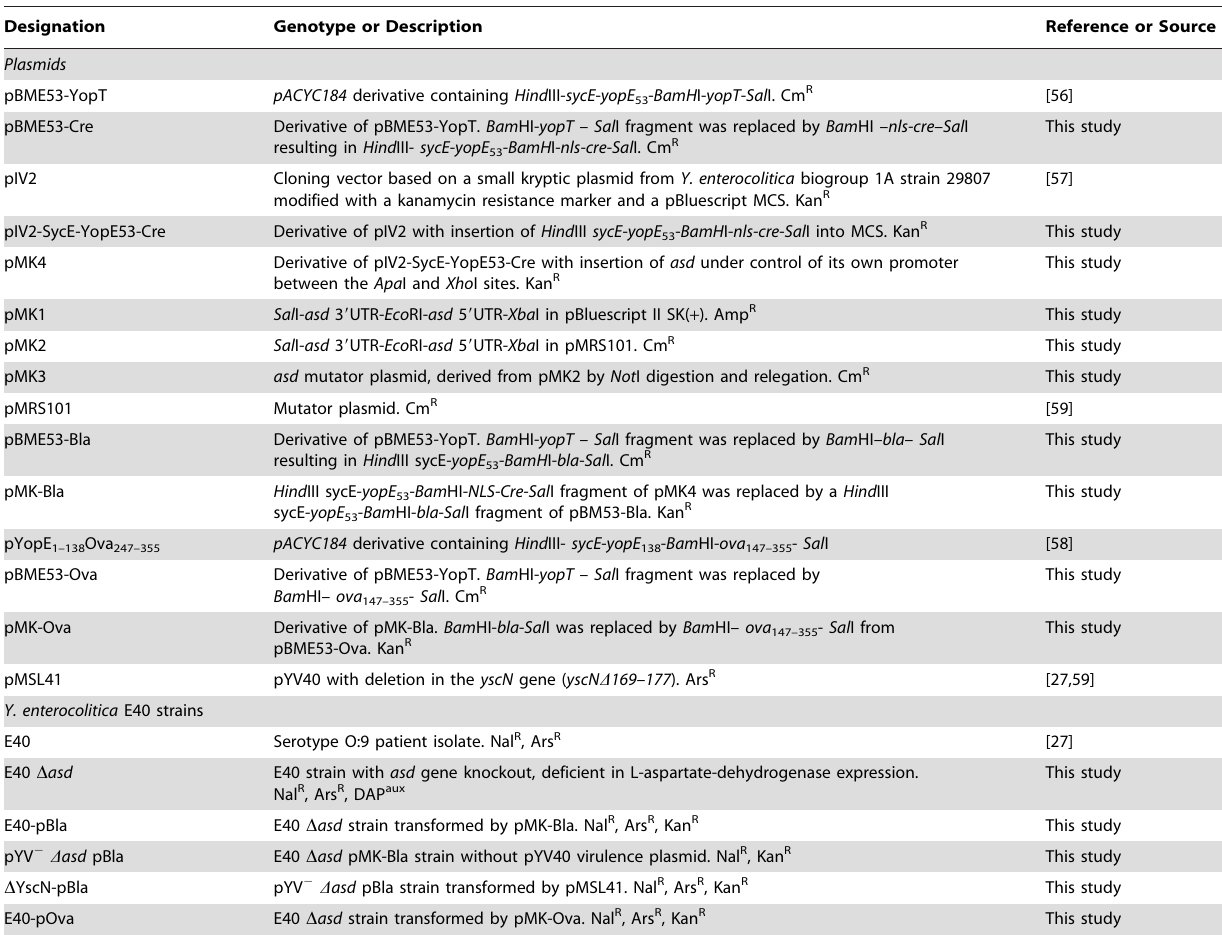
Table 1. Plasmids and bacterial strains used in this